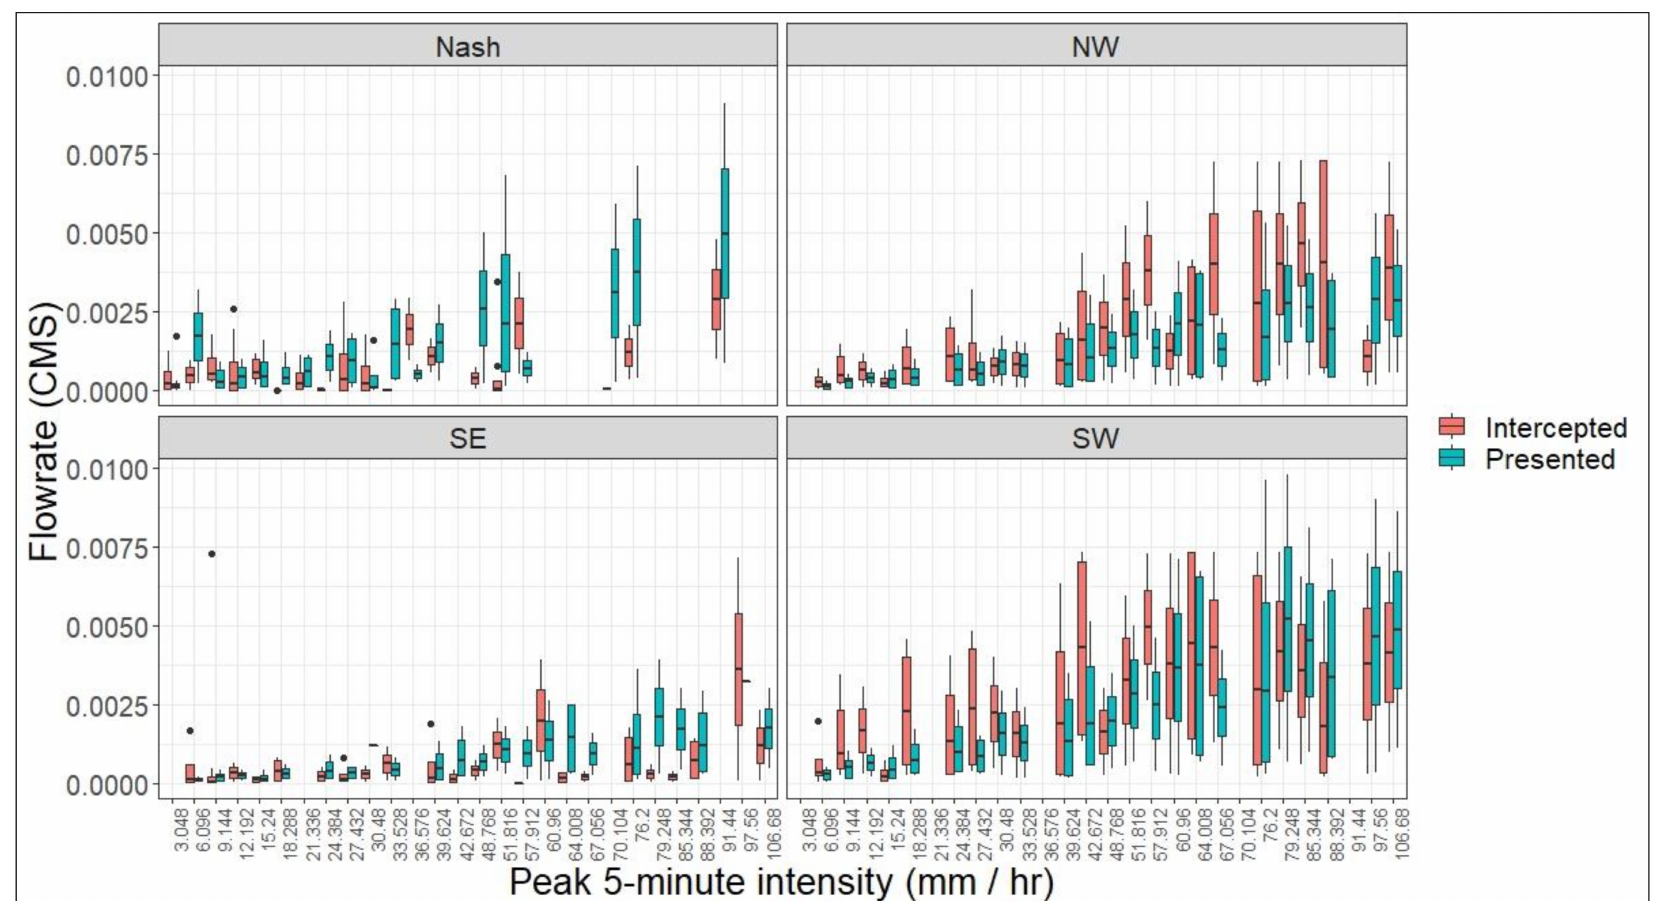
Figure 5. The distribution of presented flowrate and intercepted flowrate for all inlets ranked in order of lowest to highest peak 5 min